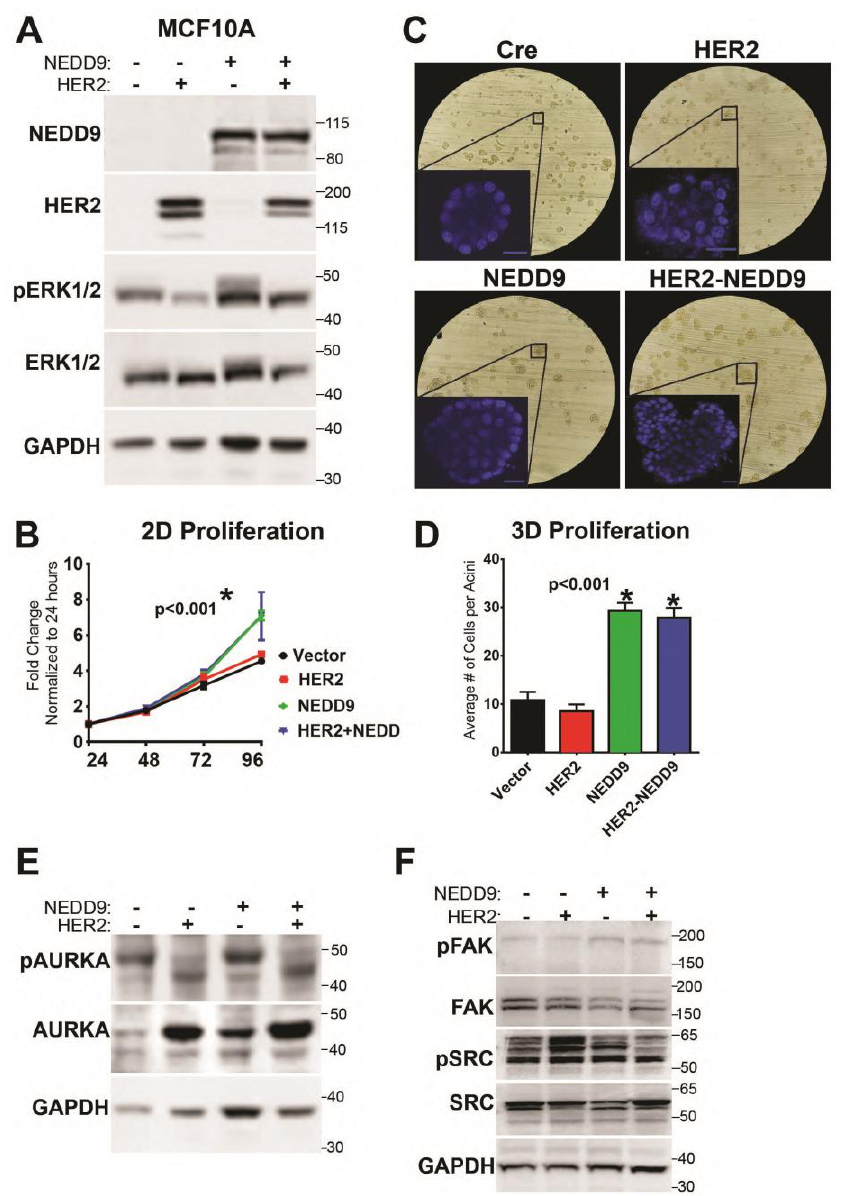
Figure 7. NEDD9 expression increases proliferation through alteration of Aurora A Kinase expression. ( A ) Western blot analysis of MCF10A cells overexpressing NEDD9, HER2, or both with anti-NEDD9, -HER2, -pERK1/2, -ERK1/2, and -GAPDH as a loading control. n = 3 independent experiments. ( B ) MTT proliferation assay using cells as in ( A ), measured at 24, 48, 72, and 96 h. Two-way ANOVA +/ − SEM, Tukey’s multiple comparisons: vector vs. NEDD9 or HER2+NEDD9—* p < 0.001 at 96 h; vector vs. HER2 is ns. ( C ) Representative brightfield images of mammary acini using cells as in ( A ), inset nuclei (blue)—DAPI (3D confocal projections every 10 mm, total of 200 mm). Scale bar—20 mm. ( D ) Quantification of number of cells per acini using confocal imaging (n = 50 acini total/cell line) in 3 independent experiments. One-way ANOVA +/ − SEM, Tukey’s multiple pairwise comparisons: vector vs. NEDD9 or HER2+NEDD9—* p < 0.001; HER2 vs NEDD9 or HER2+NEDD9—* p < 0.001. ( E ) Western blot analysis of MCF10A cells as in ( − ), with anti- pAURKA, -AURKA, -GAPDH as loading controls. ( F ) Western blot analysis of MCF10A cells with anti-pFAK, -FAK, -pSrc, -Src, and GAPDH as loading controls. The original western blots of Figure 7 is Figure